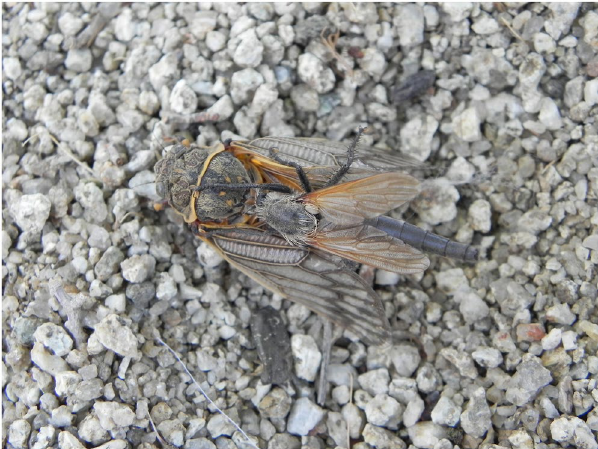
Figure 6. A male of S . yangi captured by a robber fly: Philonicus albiceps